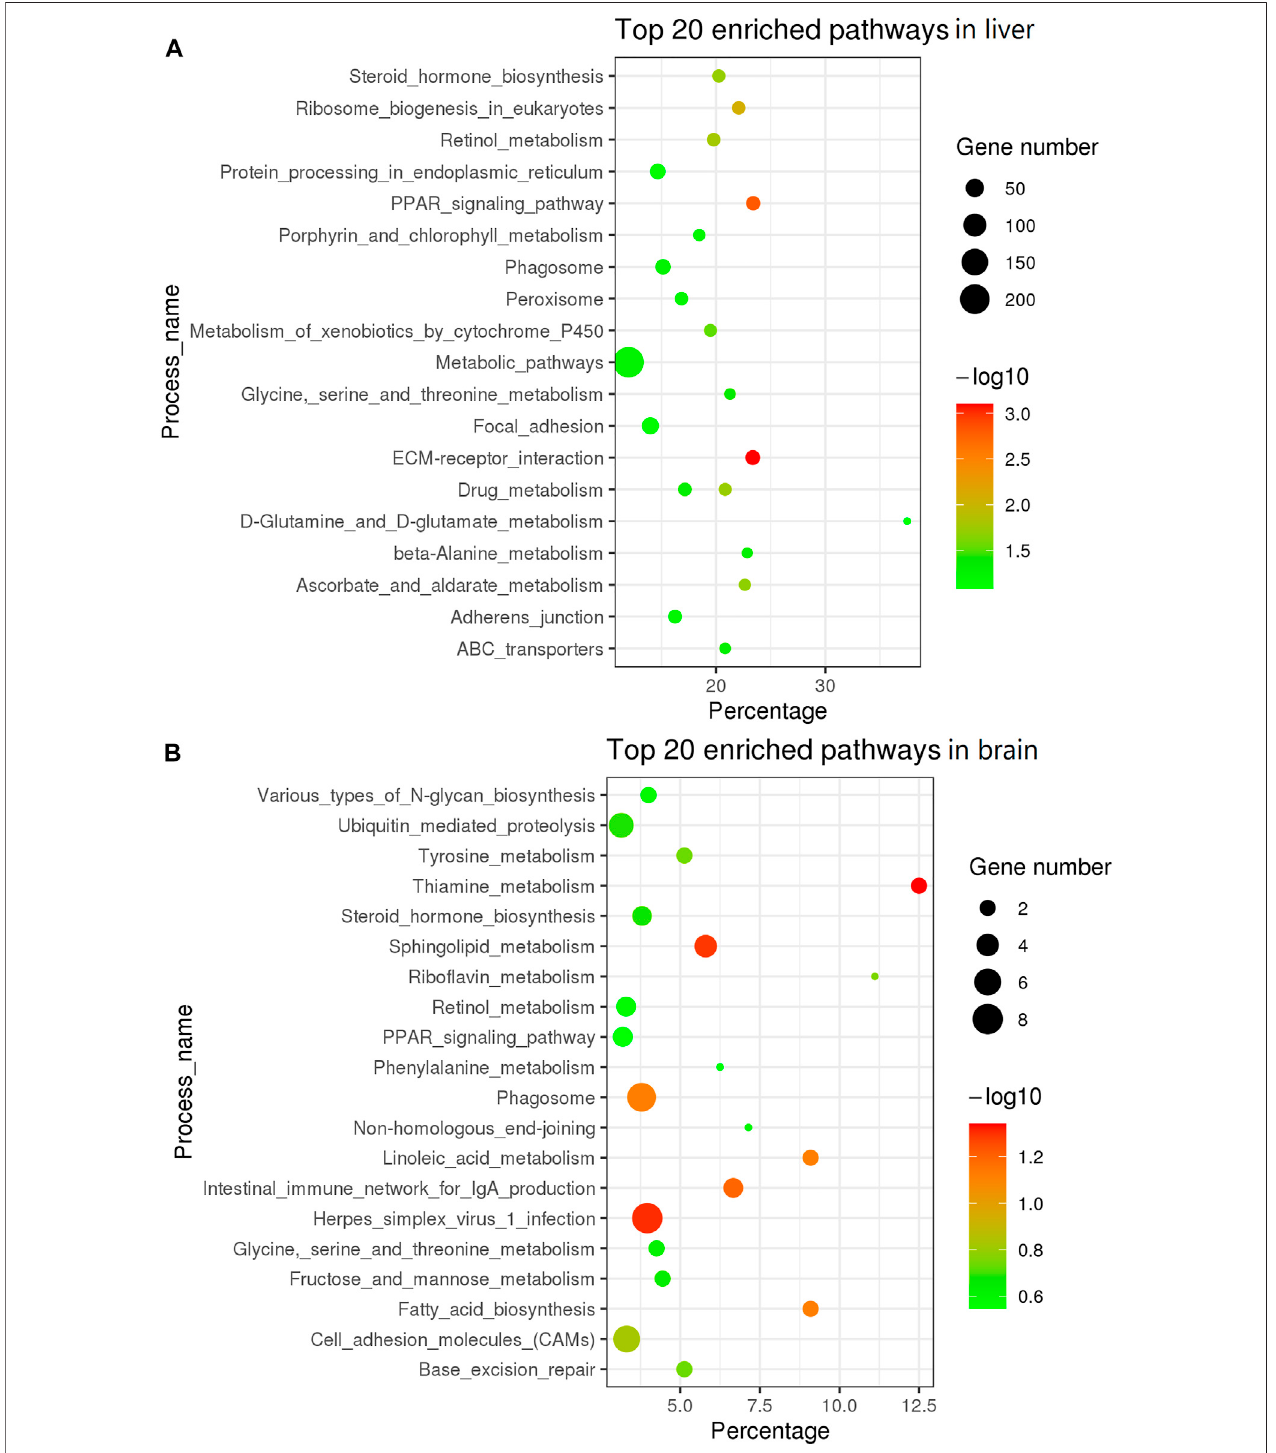
FIGURE 3 | KEGG enrichment analysis of top 20 pathway in liver and brain tissue. (A) KEGG in top 20 pathways in liver. (B) KEGG in top 20 pathways in brain tissue.